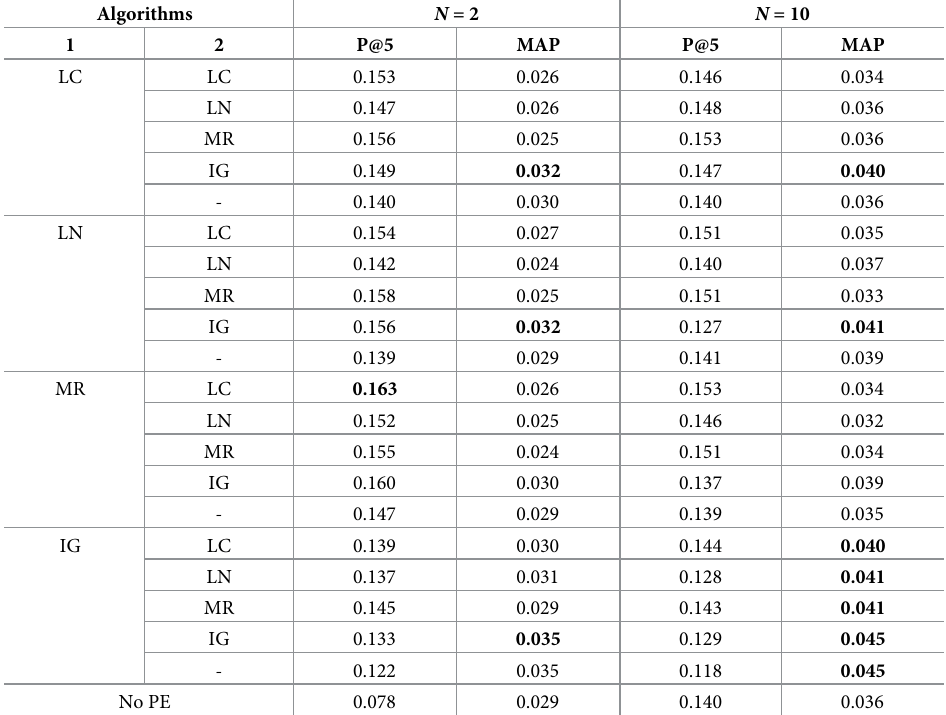
Table 2. P@5 and MAP for High Order Profile Expansion serial combinations, with l = 2. Results for simple Profile Expansion techniques are also shown, with l = 5. Significant improvements over the MR algorithm (when N = 2) and the algorithm without PE (when N = 10) are